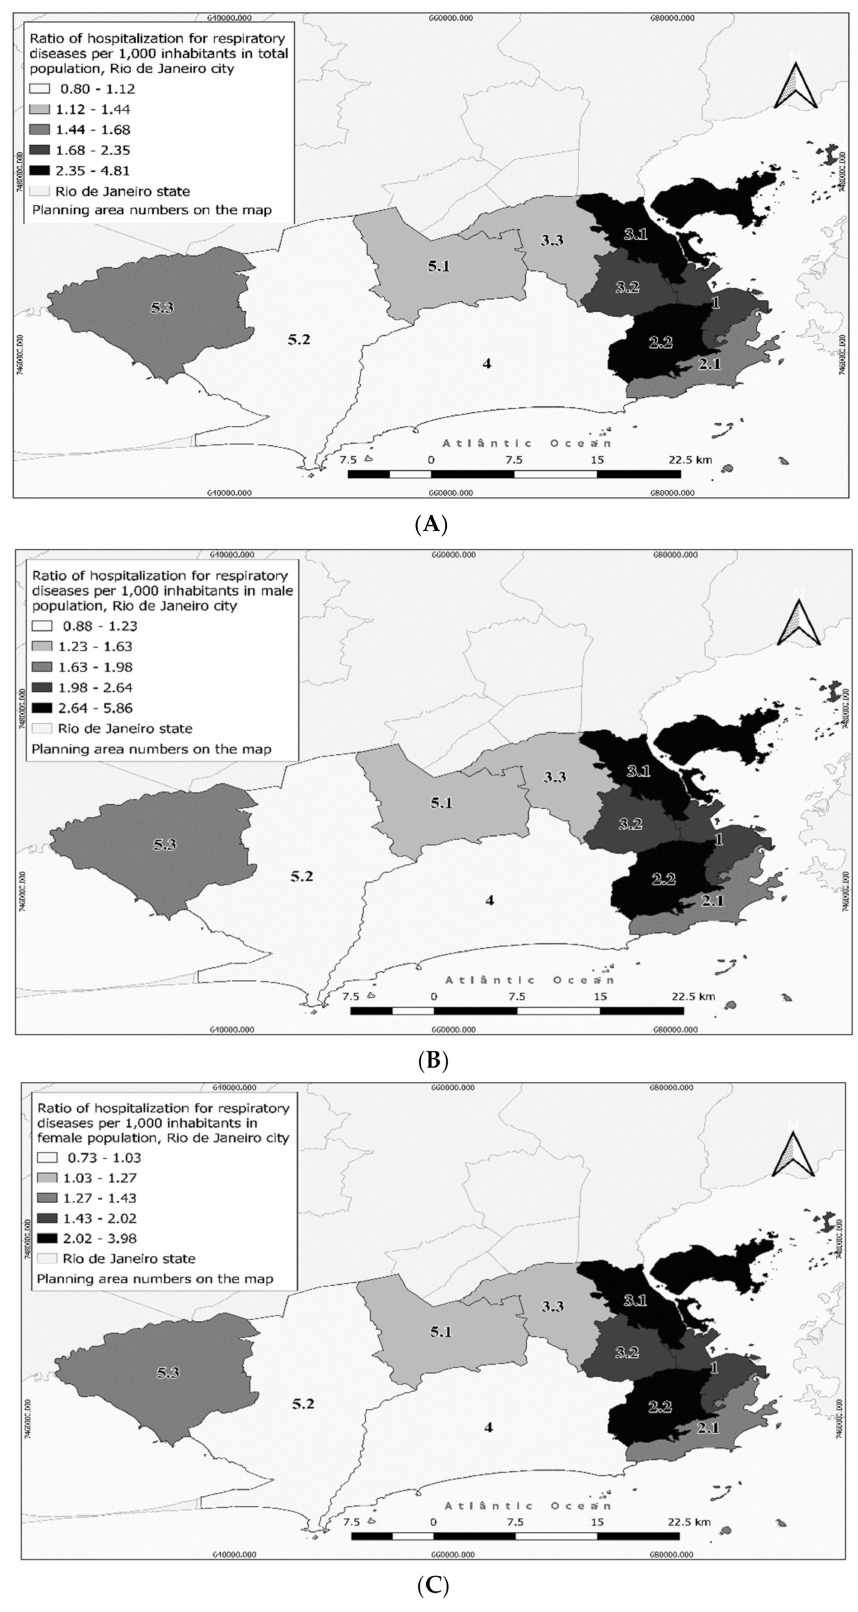
Figure 2. Ratio of respiratory hospitalizations in the city of Rio de Janeiro in 2013–2017: ( A ) general population, ( B ) male population, and ( C ) female